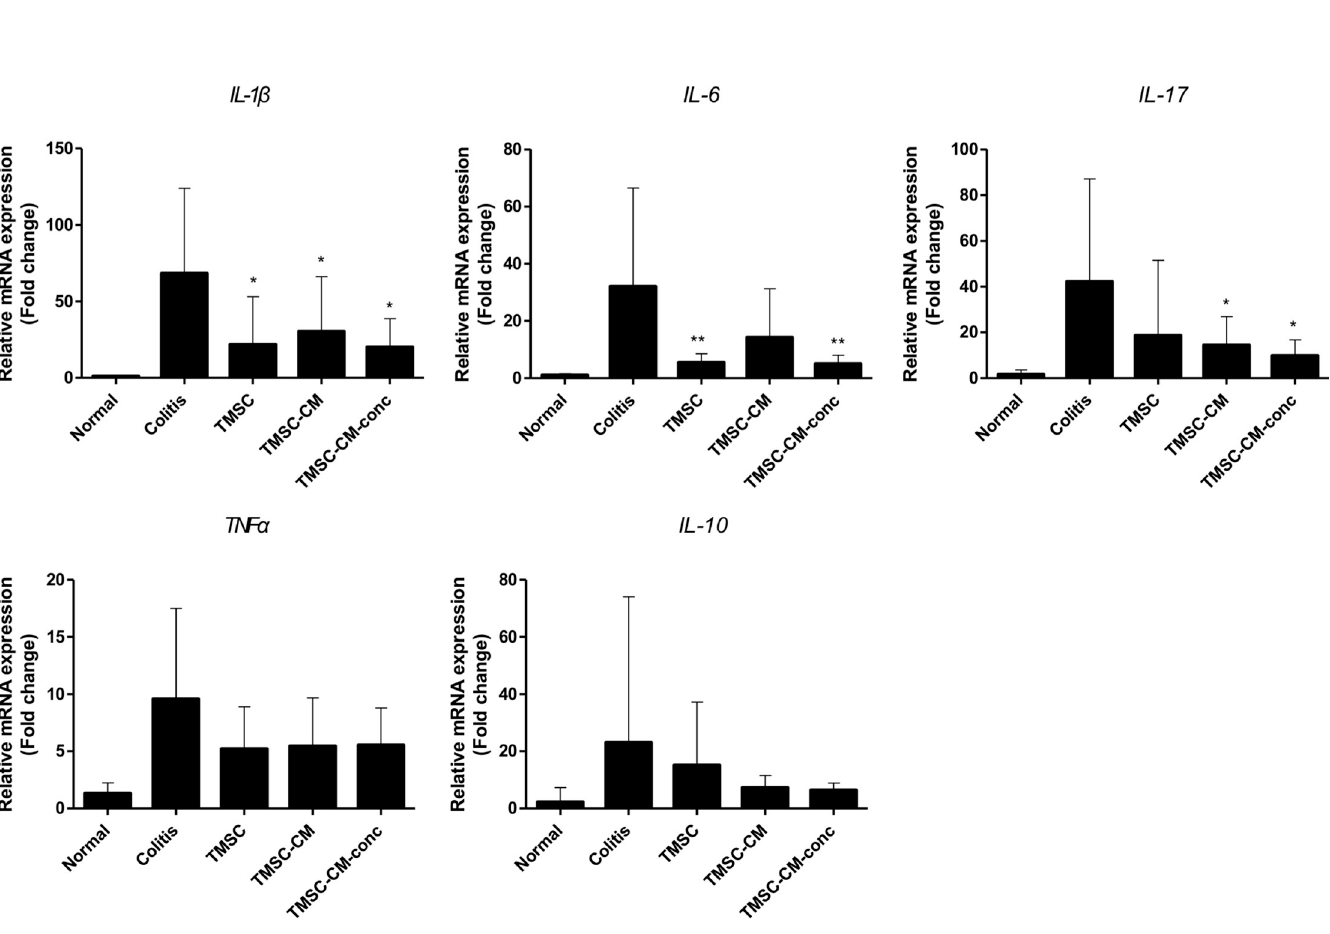
PLOS ONE | https://doi.org/10.1371/journal.pone.0225739 December2,